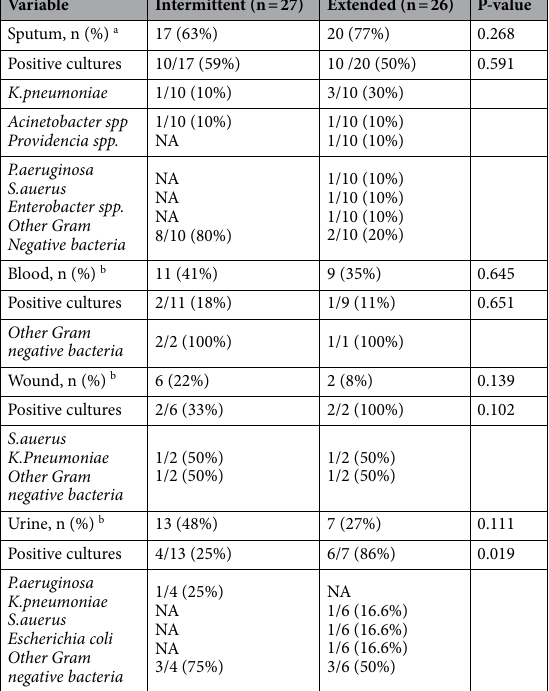
Table 3. Identified organisms from cultures and their susceptibilities. Results are expressed as mean ± SD or number (%) and were compared using a chi-square test or b Fisher’s exact test where appropriate. P-value ≤ 0.05 is considered statistically significant.